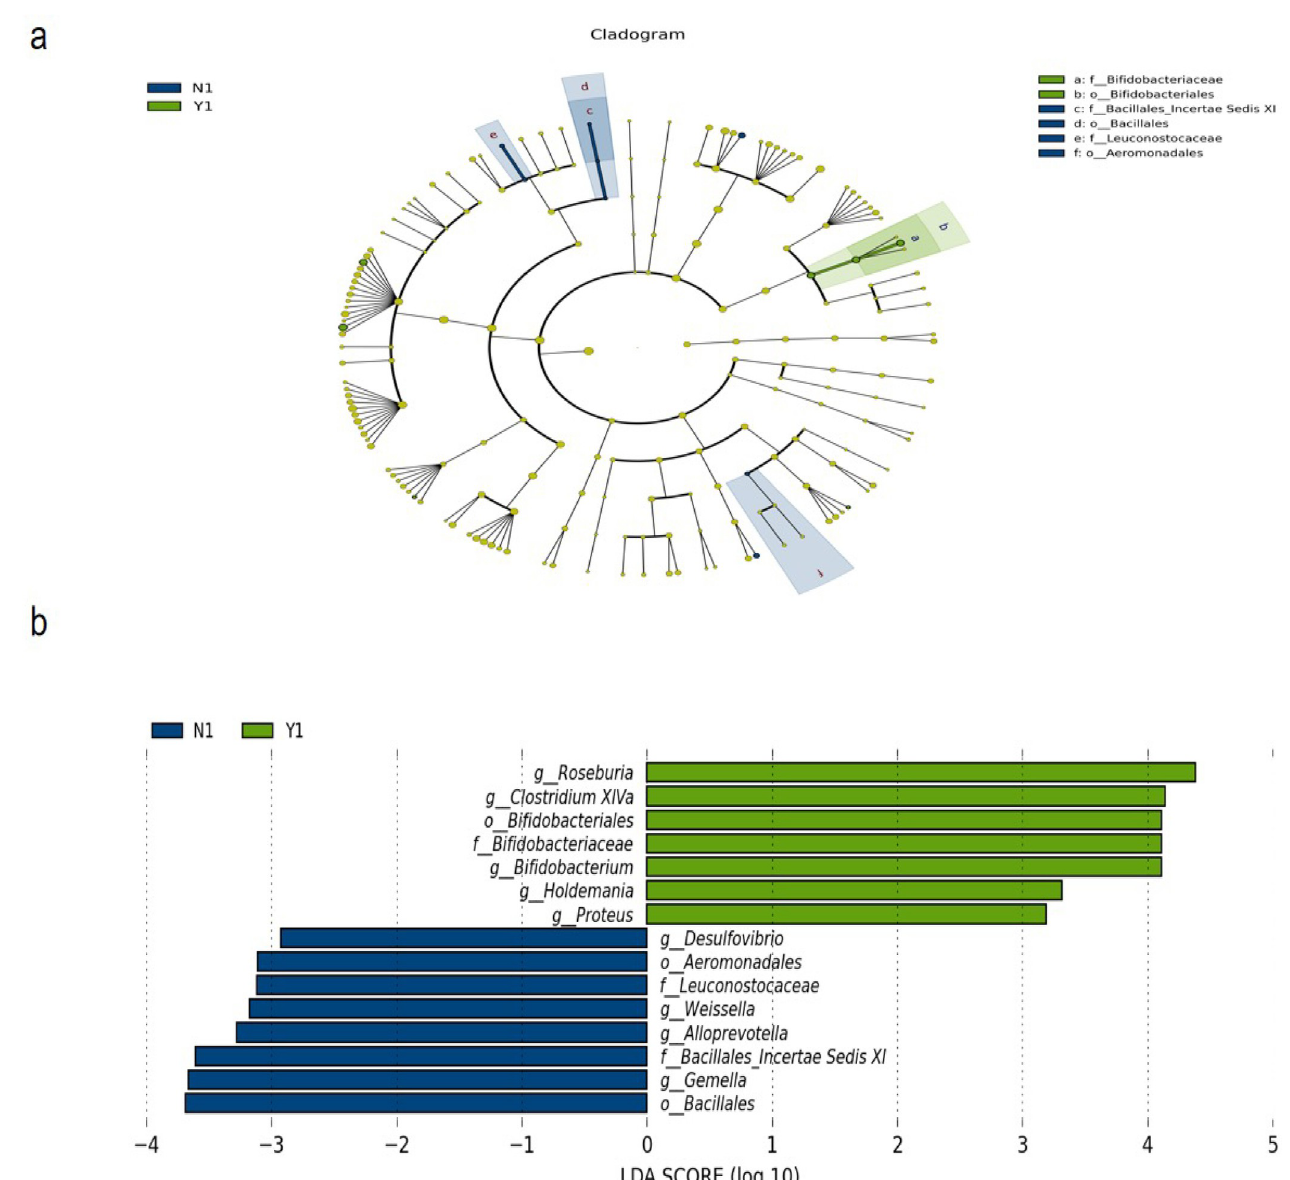
Fig 2. The results of LEfSe (LDA Effect Size) between the effective group and the ineffective group before the therapy. (a) The evolutionary branching graph showed the differences in species richness between the two groups, the circle radiating from inside to outside in the figure represents the taxonomic level from phylum to genus. The species with significant differences are colored with the group. The green node indicates the microbial groups that play an important role in the effective group, and the blue node indicates the microbial groups that play an important role in the ineffective group. (b) The histogram of the distribution of LDA values mainly shows species with significantly different LDA scores greater than a predetermined value, i.e. biomarkers that are statistically different between the effective and ineffective groups before MNT.